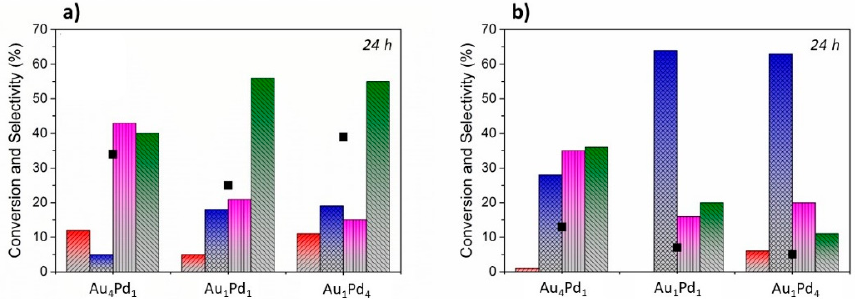
Figure 6. HMF oxidation in the aqueous phase in the absence of a base using ( a ) embedded and ( b ) supported catalysts; black—conversion, selectivity to: red—FDCA, blue—FDC, pink—HFCA, green—FFCA. Aqueous solution of HMF (30 µmol), substrate/metal = 18 (mol/mol), O 2 (1 bar), 100 °C, 600 rpm.